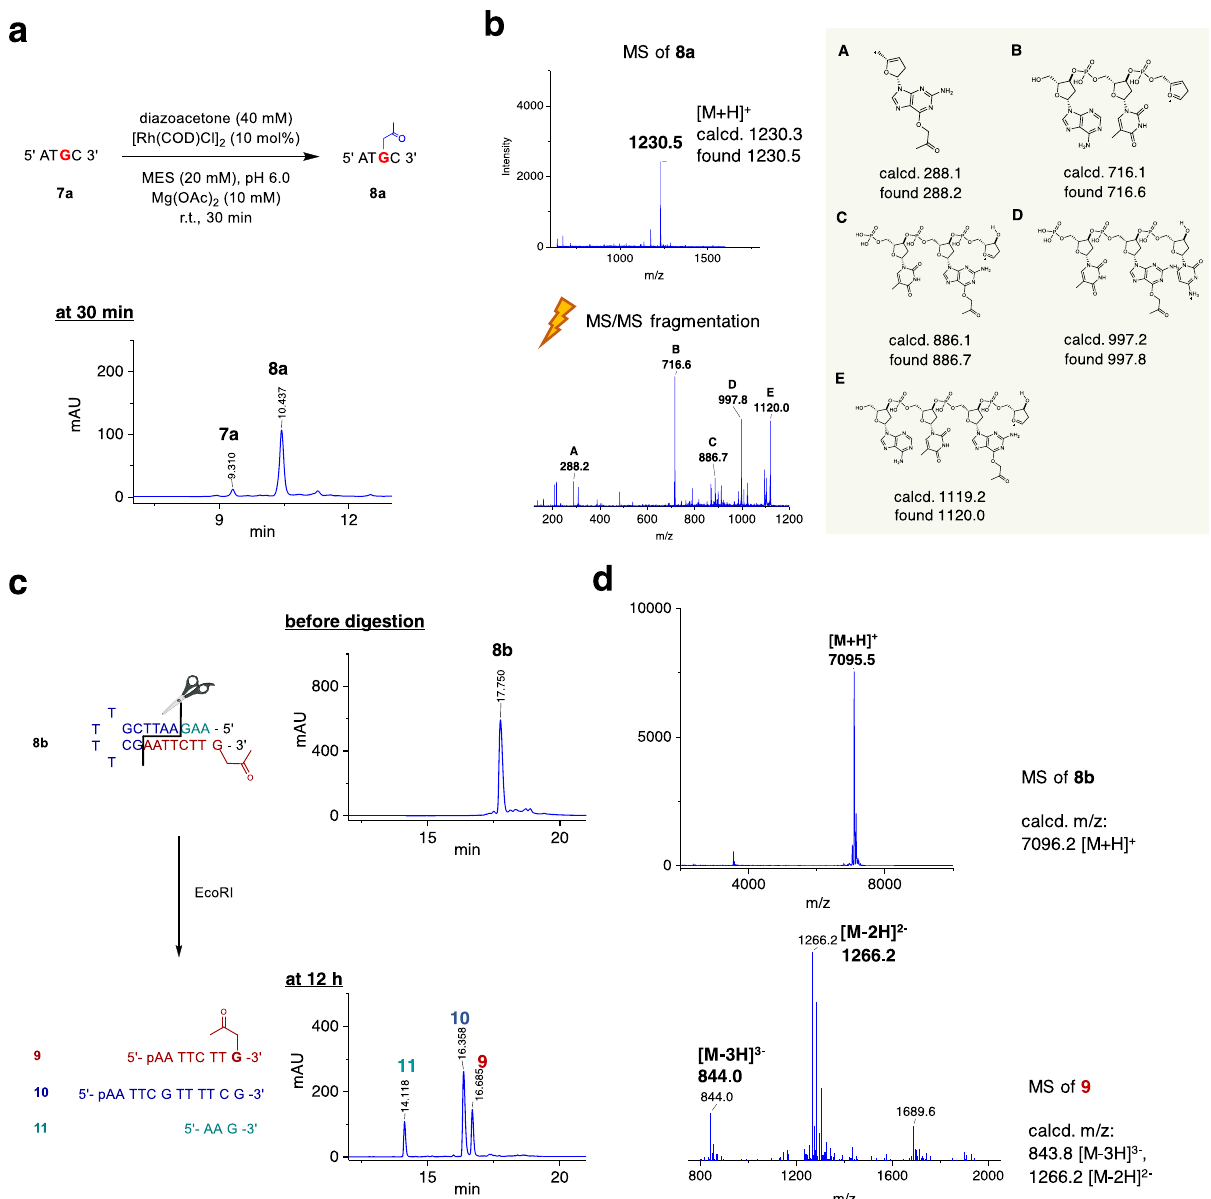
Fig. 4 Structure analysis of Rh(I)-catalyzed O 6 -G labeling of oligonucleotides. a HPLC analysis of the acetonylation of 7a . b Identi fi cation of G modi fi cation by MALDI-TOF/TOF analysis of 8a . Mass spectrum (MS) of 8a and its MS/MS fragmentation with labeled fragments. c Endonuclease digestion of acetonylated hairpin oligonucleotide 8b and the corresponding HPLC spectra for the analysis of the modi fi cation site. d MS of 8b and 9